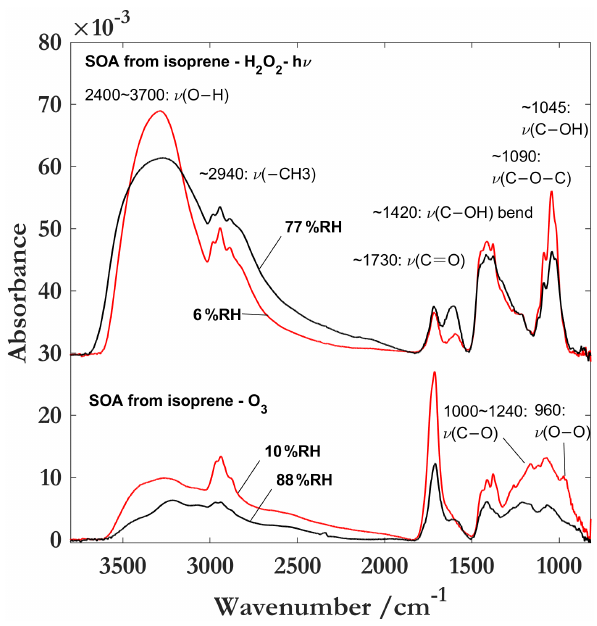
Figure 7. Infrared spectra of SOA from isoprene with different oxidants under dry and humid conditions. The bands at 1051 and 960cm − 1 are assigned to C–O and O–O groups in peroxide O–O– O (Pretsch et al.,